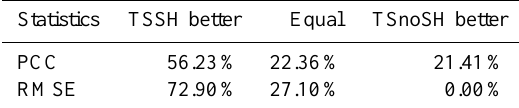
Table 5. Comparison of the PCC and RMSE between individual profiles derived from two tomographic solutions and radiosonde